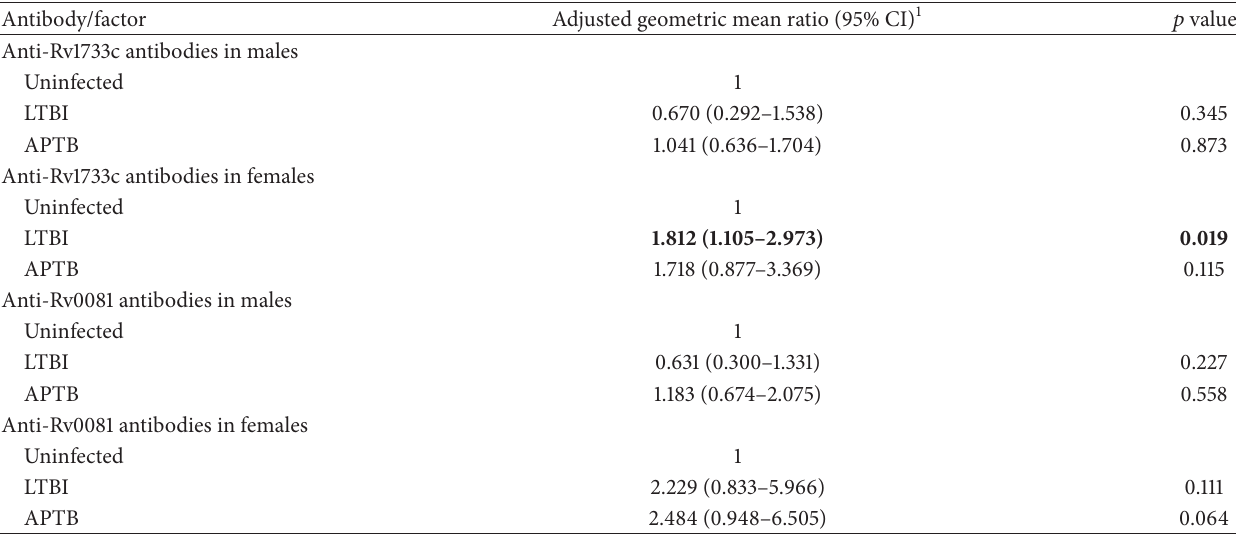
Table 3: Associations between Mycobacterium tuberculosis infection status and concentrations of IgG antibodies to Rv1733c and Rv0081 DosR proteins in male and female study participants, after adjusting for potential